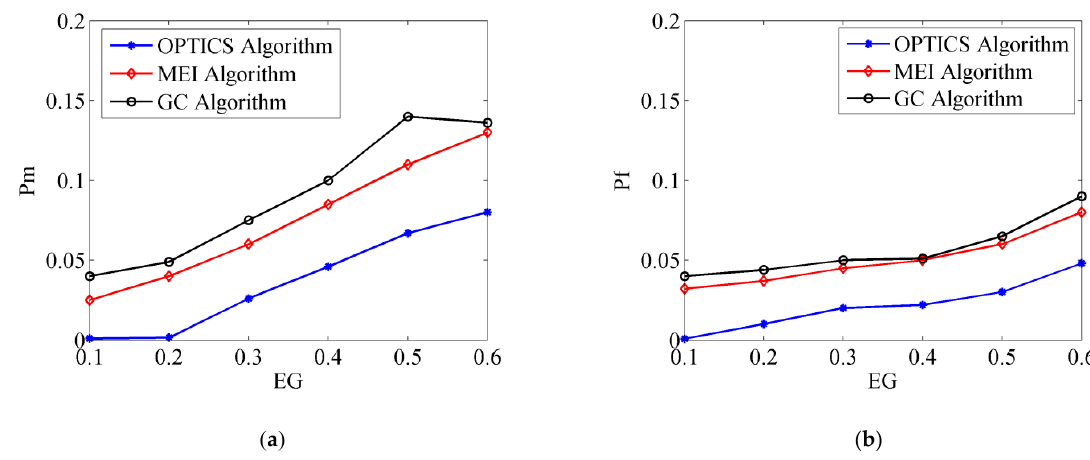
Figure 8. P m and P f with di ff erent EGs. ( a ) P m V.S. EG. ( b ) P f V.S. P Figure 8. m